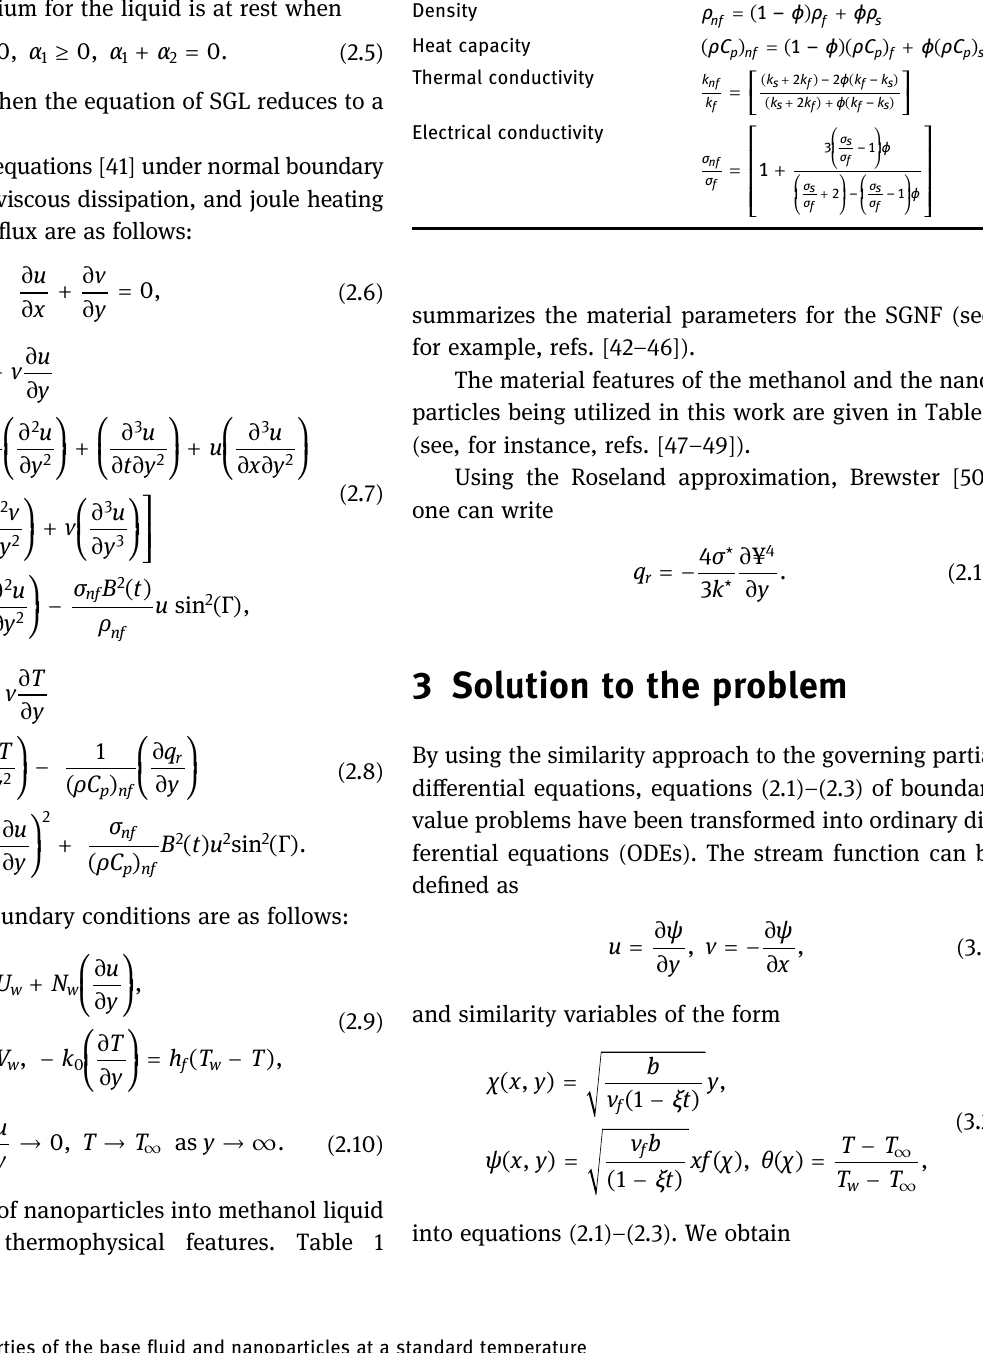
Table 2: Primary properties of the base fl uid and nanoparticles at a standard temperature Thermophysical